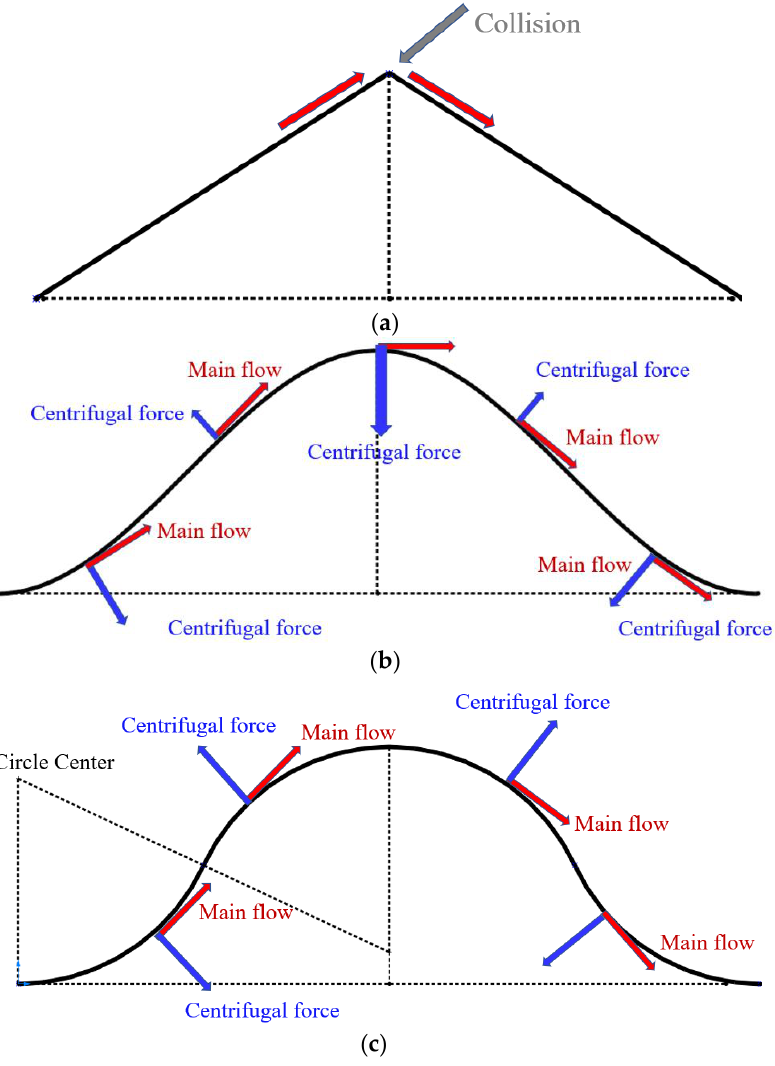
Figure 21. Force analysis of He–Xe in different tubes. ( a ) Zig channel. ( b ) Sine channel. ( c ) Serpentine channel.